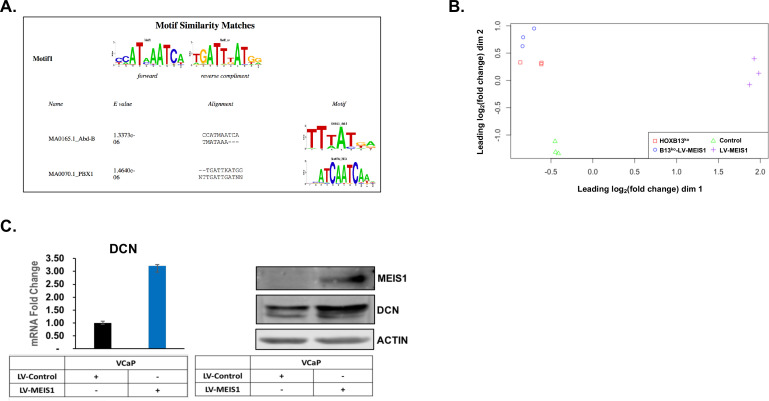
HOXA9 motif shares similarity, RNA-seq MDS plot, and Validation of DCN expression in VCaP.(A) The web-based tool STAMP for alignment, similarity, and database-matching of DNA motifs was used to identify other motifs that share similarity to the HOXA9 motif inferred in SpaMo analysis of MEIS1 ChIP-seq from HOXB13ko-LV-MEIS1 cells. (B) Multidimensional scaling (MDS) plot generated by edgeR from differential gene expression analysis of RNA-seq shows nice clustering by cell line identity. (C) Western blot of Increased DCN expression resulting from LV-MEIS1 transfection was validated in VCaP cells. Actin was used as a loading control.